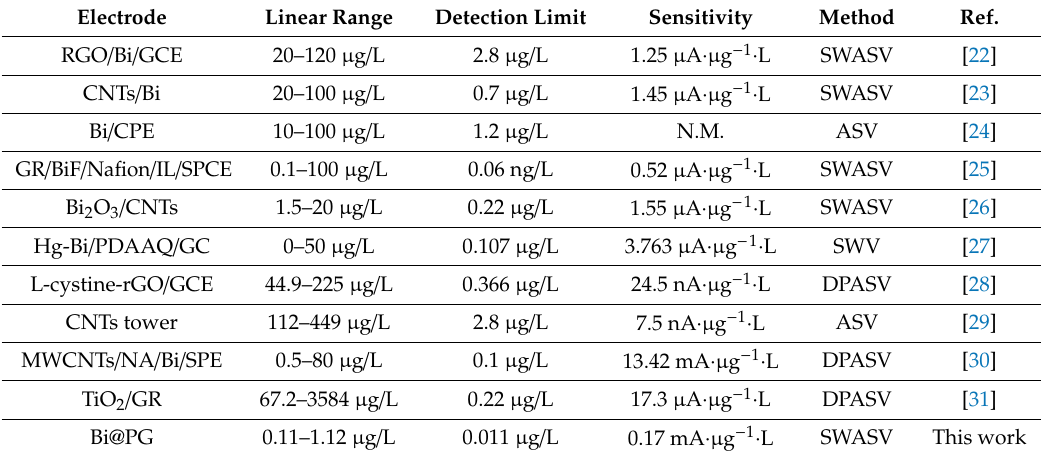
Table 1. Comparison of different electrodes based on Bi or carbon material for the determination of Cd 2 + .